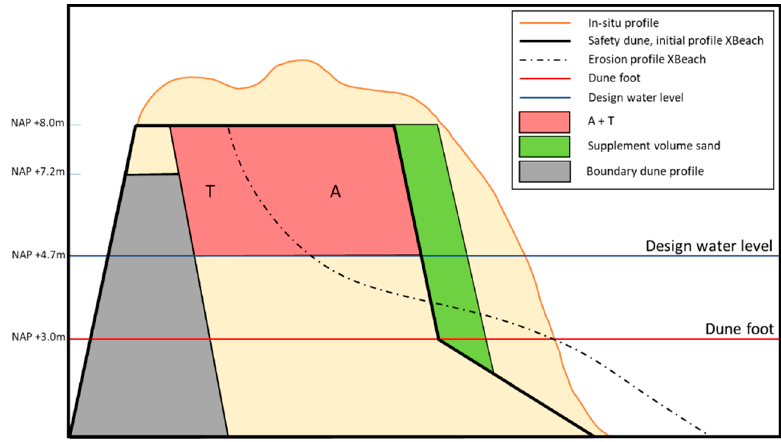
Figure 15. Cross shore profile of beach-dune system at transect 15; ( upper ) dune and beach profile; ( lower ) dune above +3 m NAP.